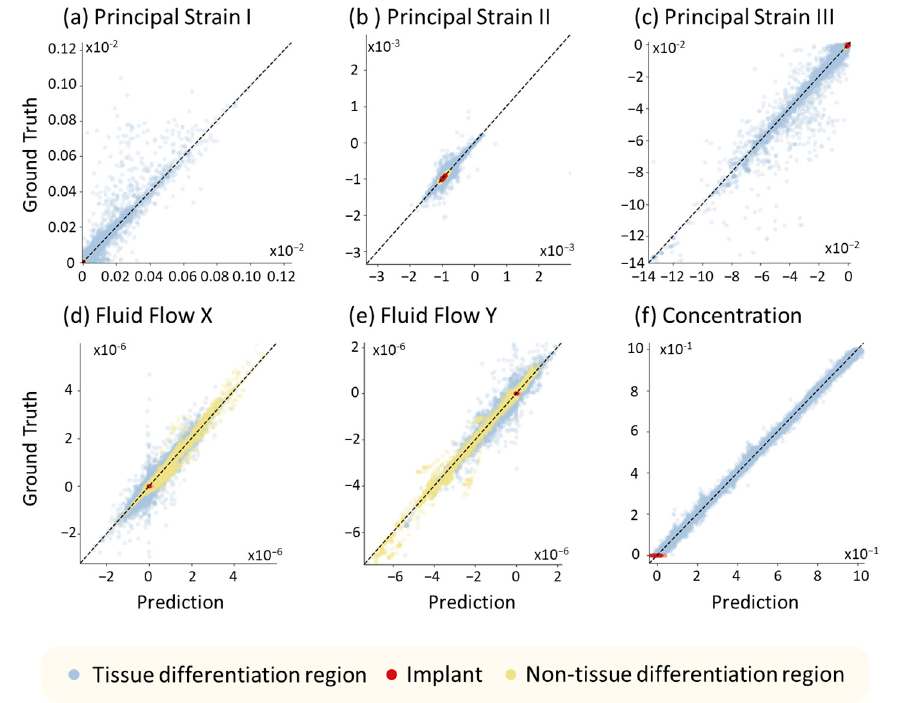
Figure 2. Correlation plot between the predicted values and ground truths calculated by finite element analysis (FEA), where ( a – f ) are principle strain I, II, III, fluid velocity in the x and y directions, and stem cell concentration. The data include the elements in the tissue differentiation (blue), implant (red), and non-tissue differentiation (yellow) regions.